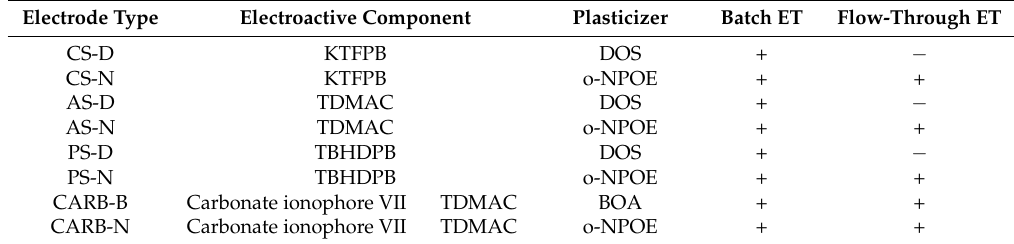
Table 1. Sensor arrays of the electronic tongue